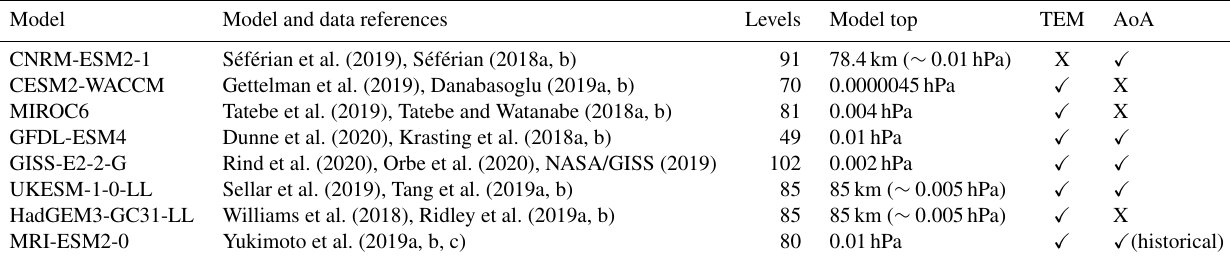
Table 1. List of CMIP6 models with Transformed Eulerian Mean (TEM) and/or age of air (AoA) diagnostics used in this study. AoA is only provided in the historical runs for